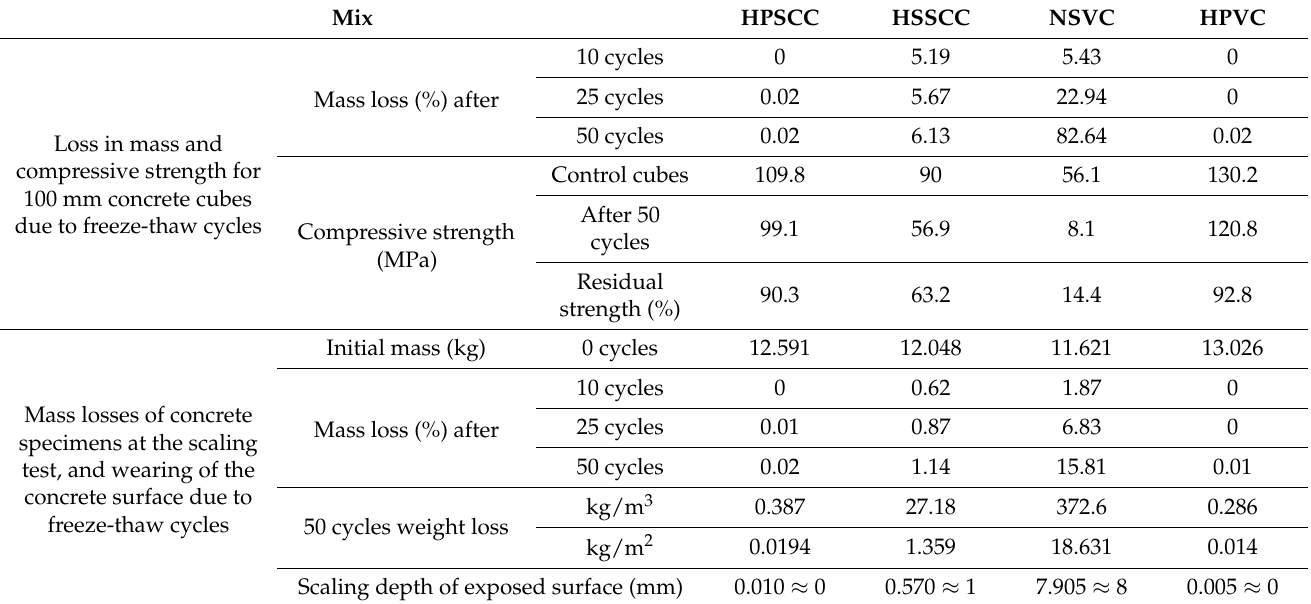
Table 9. Loss in mass and compressive strength for 100 mm concrete cubes due to freeze-thaw cycles, Mass losses of concrete specimens the scaling test, and Wearing of the concrete surface due to freeze-thaw cycles. Mix HPSCC HSSCC